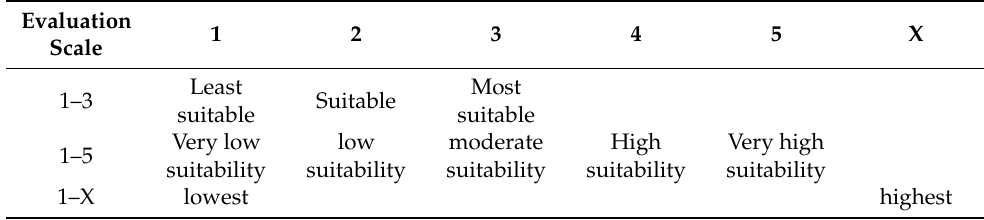
Table 13. Evaluation scale